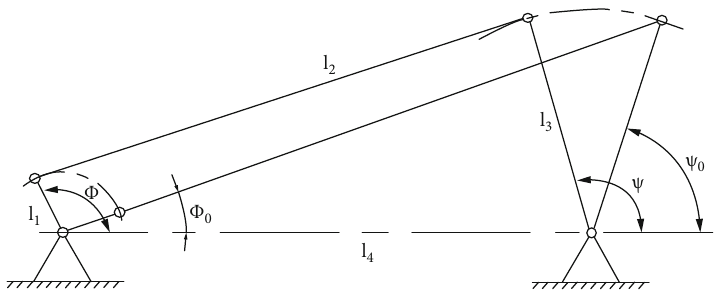
Figure 22: Right limit position of the